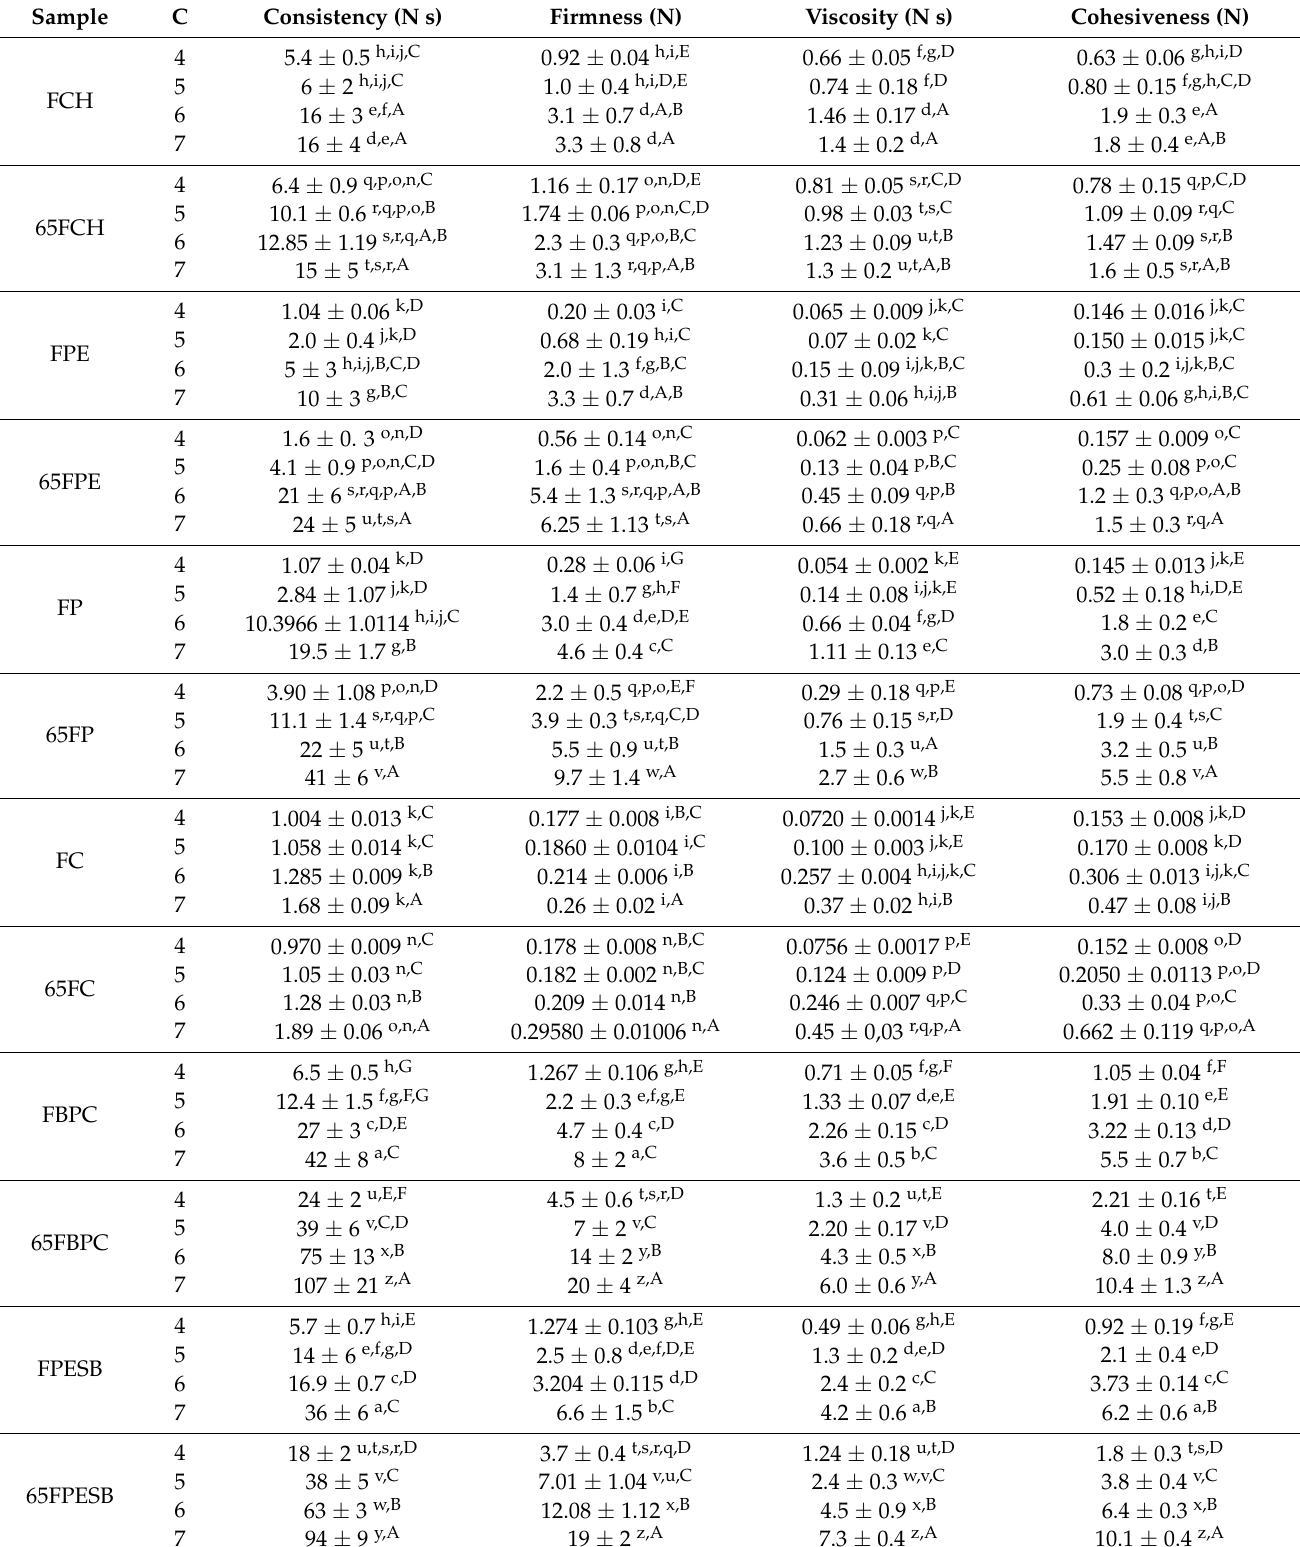
Table 5. Mean values ± standard deviations of the back extrusion parameters of the formulated